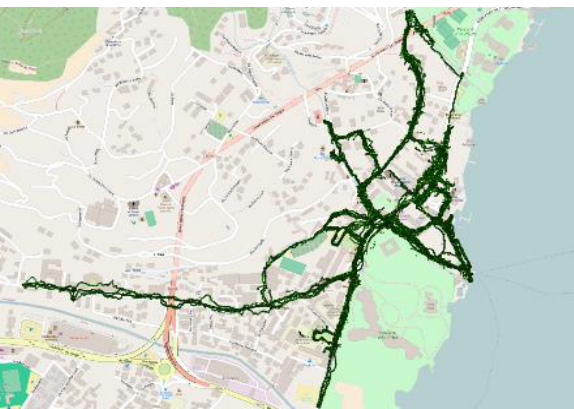
Figure 11. GPS data collected in Cernobbio (Como, Italy) with MEP Traces.